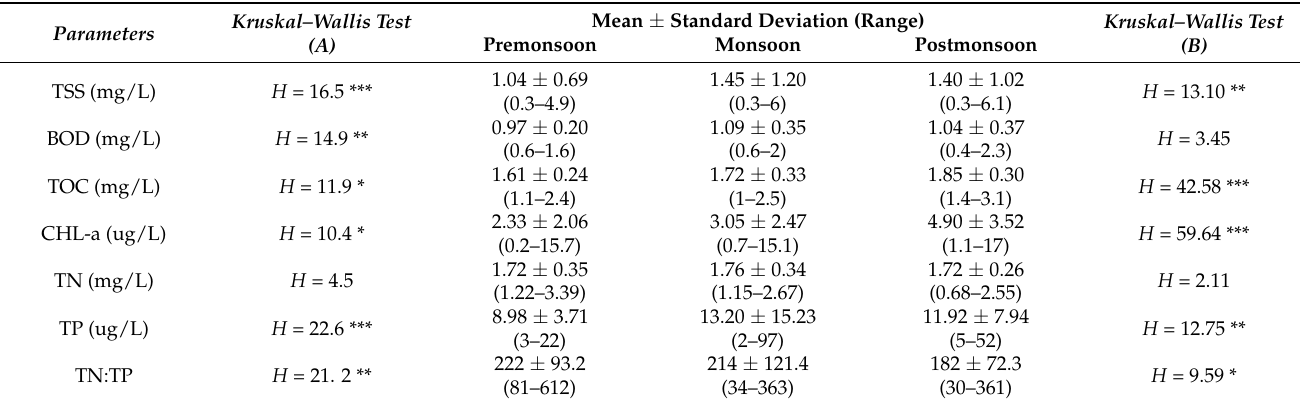
Table 2. The variance analysis of nutrients, organic matters (BOD, TOC), and CHL-a for spatial (A) and seasonal-monsoon (B) patterns in the